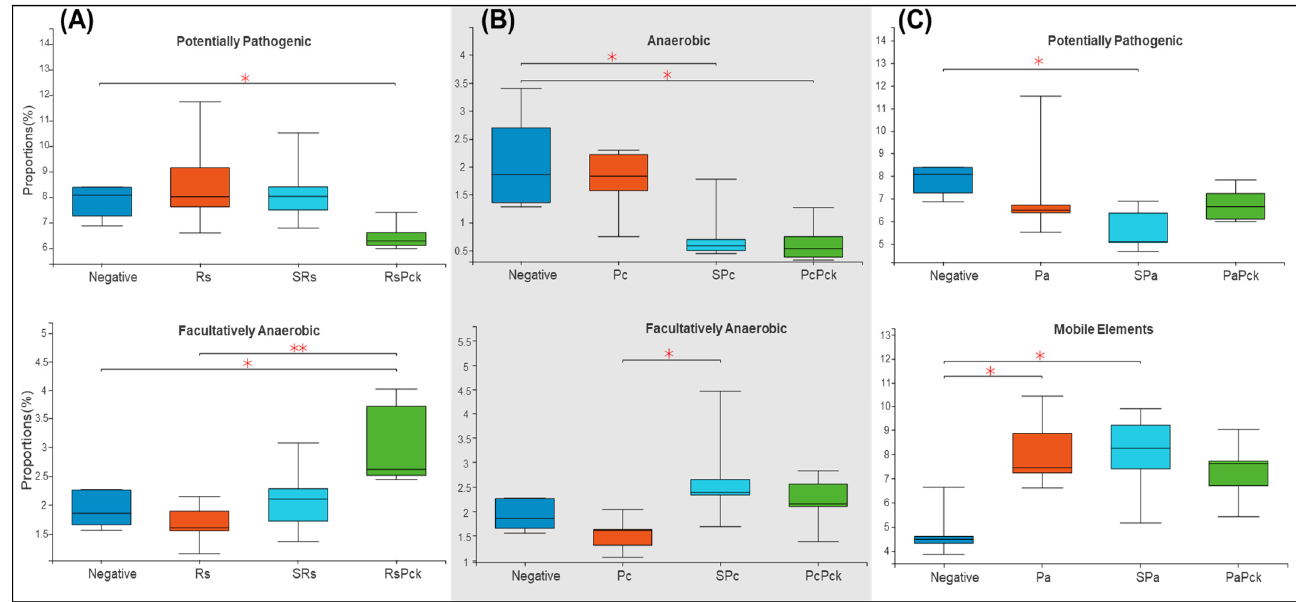
Figure 5. Boxplot diversity explained by phenotypic prediction among the phage therapy treatments. ( A ) Proportions of the potentially pathogenic and facultatively anaerobic phenotype of R. solanacearum phage therapy (Rs) treatments. ( B ) Proportions of anaerobic and facultatively anaerobic phenotypes of P. carotovorum phage therapy. ( C ) Proportions of the potentially pathogenic and facultatively anaerobic phenotype of P. atrosepticum phage therapy (* p -value < 0.05, ** p -value < 0.001). The second group (Pc) showed that both single phage (SPc) and phage cocktail